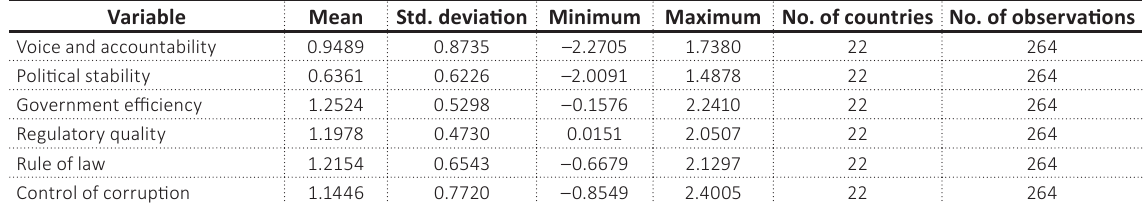
Table 2. Summary statistics: world governing indices Variable Mean Std. deviation Minimum Maximum No. of countries No. of